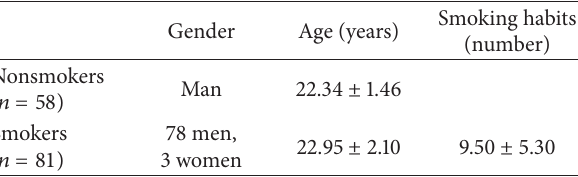
Table 1: Demographics of